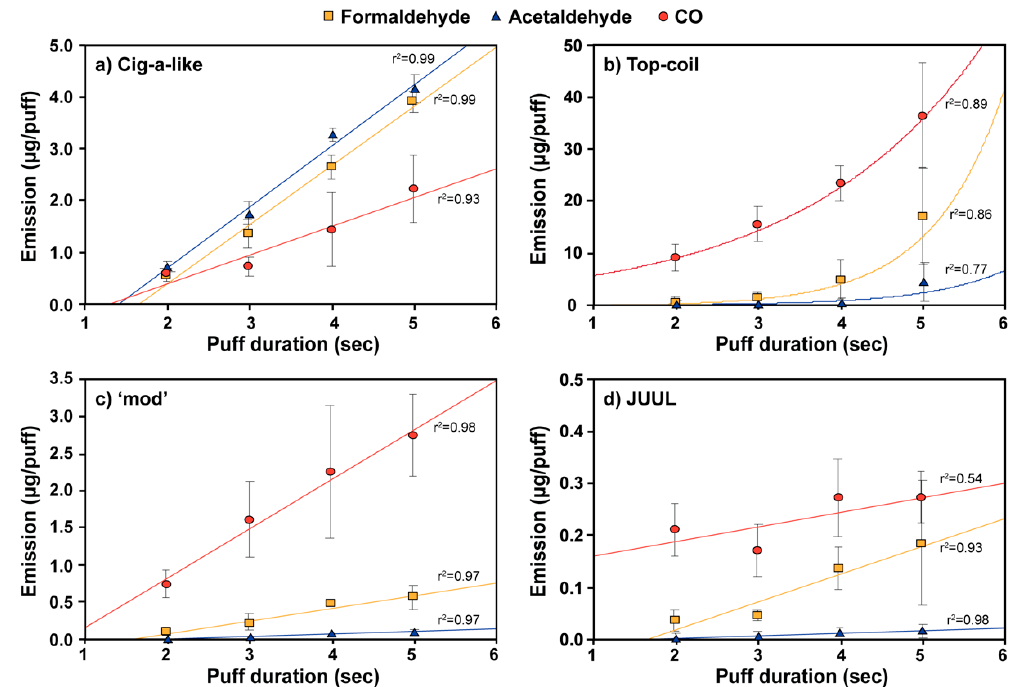
Figure 2. Dependence of carbonyl and CO emissions on pu ff duration for the ( a ) cig-a-like, ( b ) top-coil, ( c ) ‘mod’, and ( d ) JUUL ‘pod’ e-cigarette devices at 25 mL / s pu ff flow rate (error bars represent standard deviation of three independent measurements). The 50-watt power output was used for ‘mod’ device. Linear and, in the case of the top-coil device, exponential regression lines for each compound are also shown.